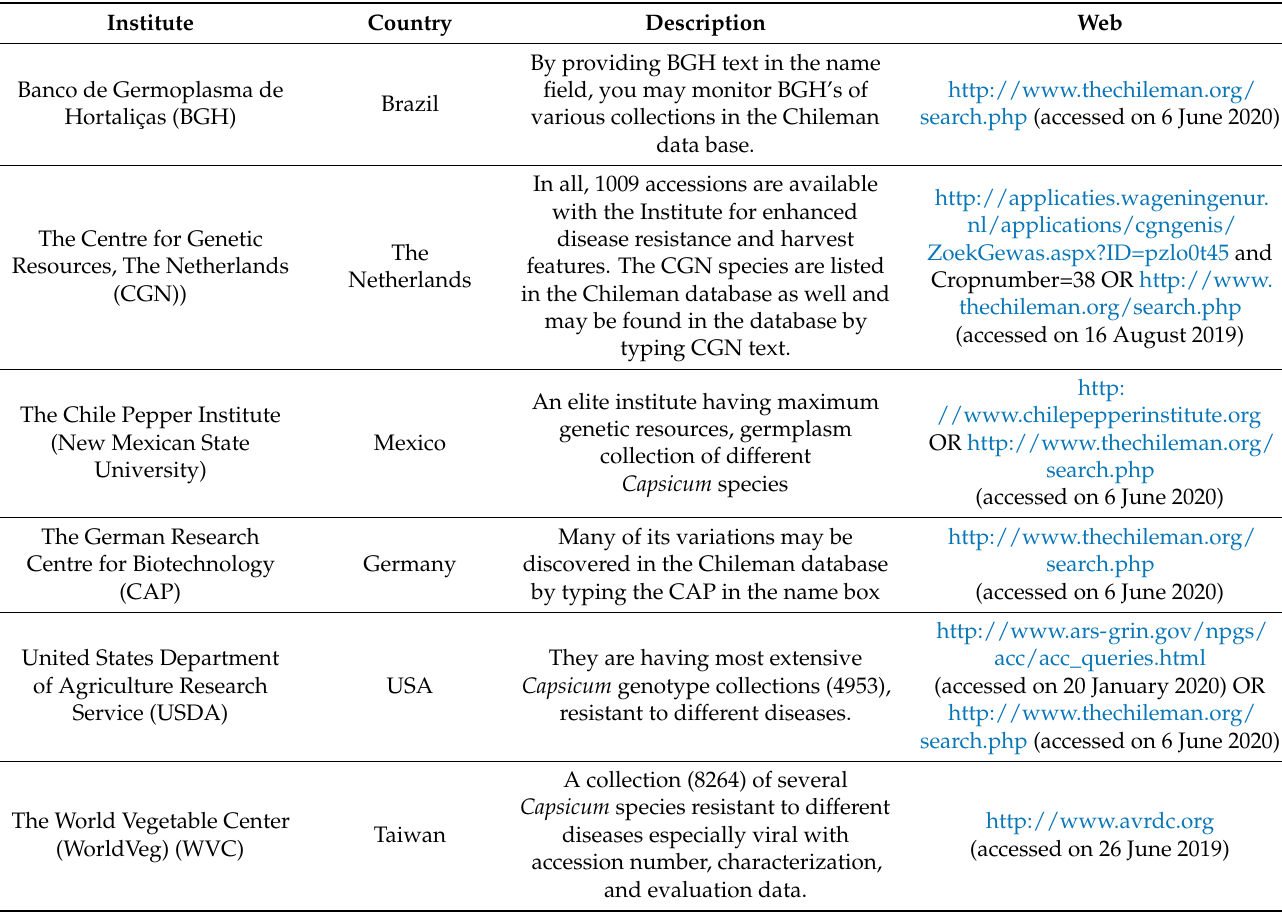
Table 1. List of resources and germplasm databases of Capsicum adopted from Chhapekar et al. [24], (Publisher: Daya Publishing House,